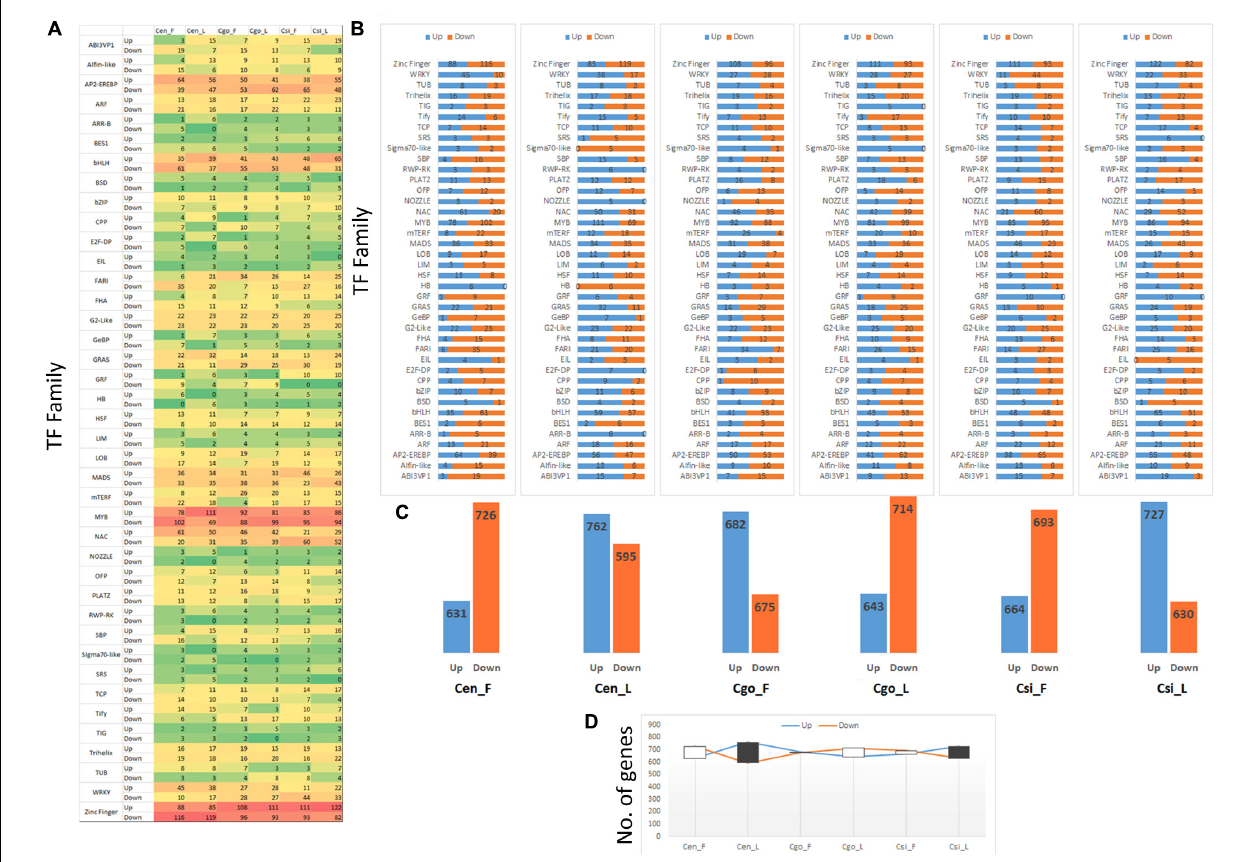
FIGURE 5 | Statistics of 40 transcription factor (TF) families (A) , upregulation and downregulation trend of individual TF family (B) , difference in the upregulation and downregulation for each tissue (C) , and the trend of comparative upregulation and downregulation (D)